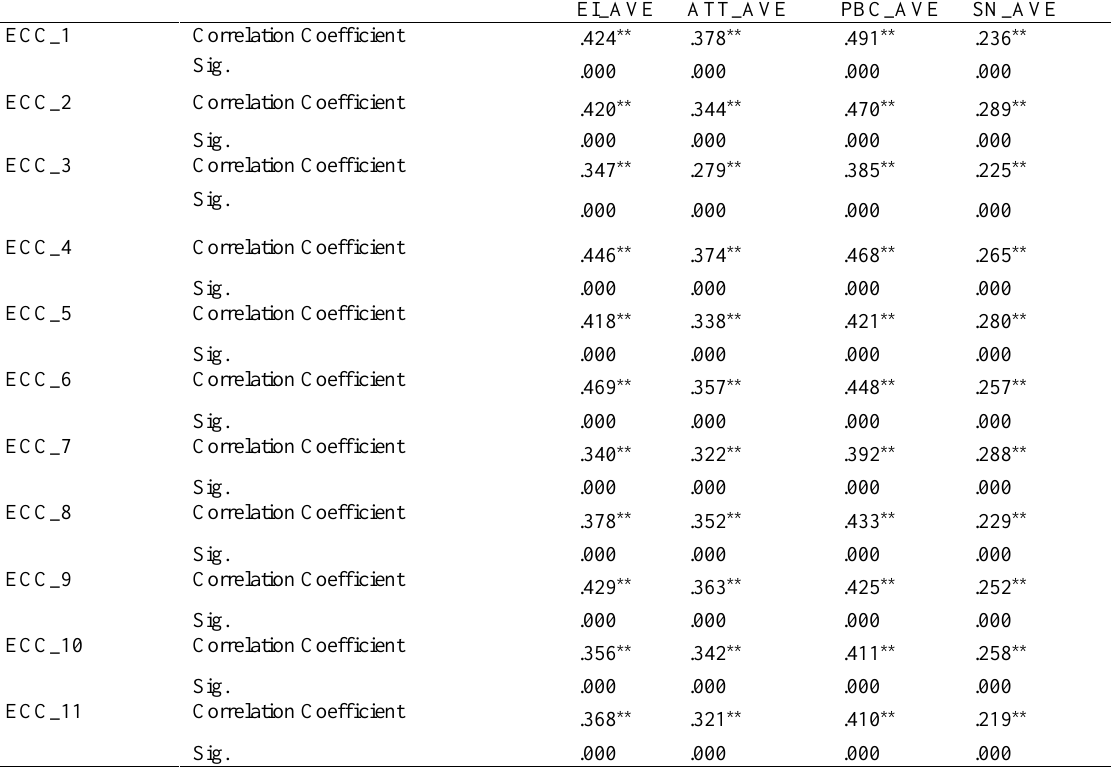
Table 3: Correlations Statistics between Entrepreneurial Course Content and Individual Entrepreneurial Characteristics EI_AVE ATT_AVE PBC_AVE SN_AVE ECC_1 Correlation Coefficient .424 ** .378 ** .491 ** .236 ** Sig. .000 .000 .000 .000 ECC_2 Correlation Coefficient .420 ** .344 ** .470 ** .289 ** Sig. .000 .000 .000 .000 ECC_3 Correlation Coefficient .347 ** .279 ** .385 ** .225 ** Sig. .000 .000 .000 .000 ECC_4 Correlation Coefficient .446 ** .374 ** .468 ** .265 ** Sig. .000 .000 .000 .000 ECC_5 Correlation Coefficient .418 ** .338 ** .421 ** .280 ** Sig. .000 .000 .000 .000 ECC_6 Correlation Coefficient .469 ** .357 ** .448 ** .257 ** Sig. .000 .000 .000 .000 ECC_7 Correlation Coefficient .340 ** .322 ** .392 ** .288 ** Sig. .000 .000 .000 .000 ECC_8 Correlation Coefficient .378 ** .352 ** .433 ** .229 ** Sig. .000 .000 .000 .000 ECC_9 Correlation Coefficient .429 ** .363 ** .425 ** .252 ** Sig. .000 .000 .000 .000 ECC_10 Correlation Coefficient .356 ** .342 ** .411 ** .258 ** Sig. .000 .000 .000 .000 ECC_11 Correlation Coefficient .368 ** .321 ** .410 ** .219 ** Sig. .000 .000